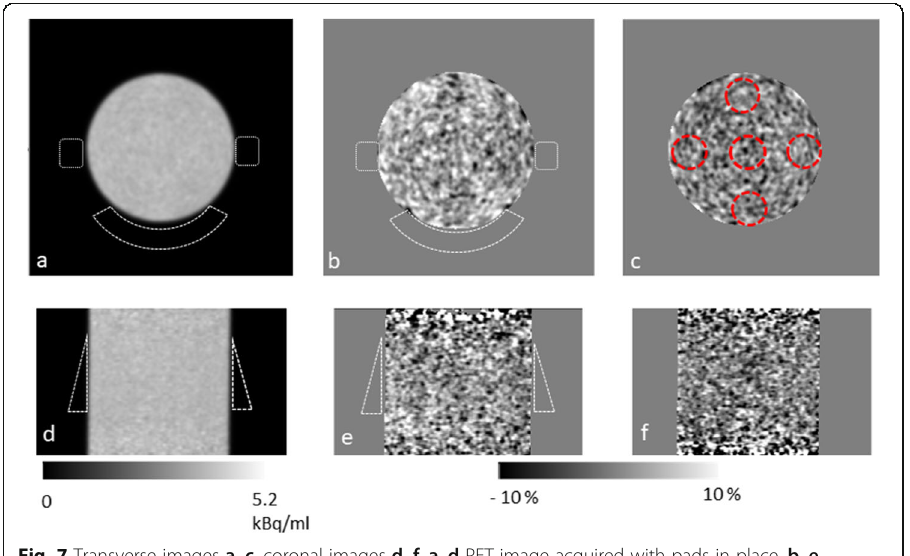
Fig. 7 Transverse images a – c , coronal images d – f . a , d PET image acquired with pads in place. b , e Difference between PET images with/without pads attached to phantom. c, f Subtraction of two PET images acquired back to back. Dotted white lines represent the position of the pads in a , b , d and e . Dotted red lines in c show the positions of ROIs used to make measurements given in Table